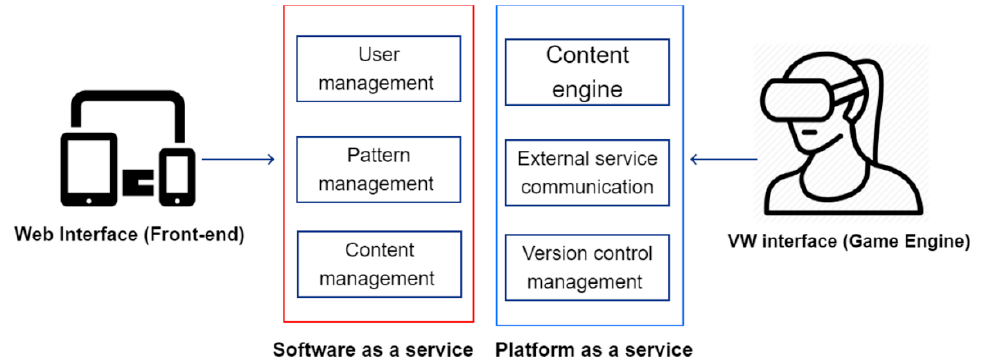
Figure 3. Web platform component software design.